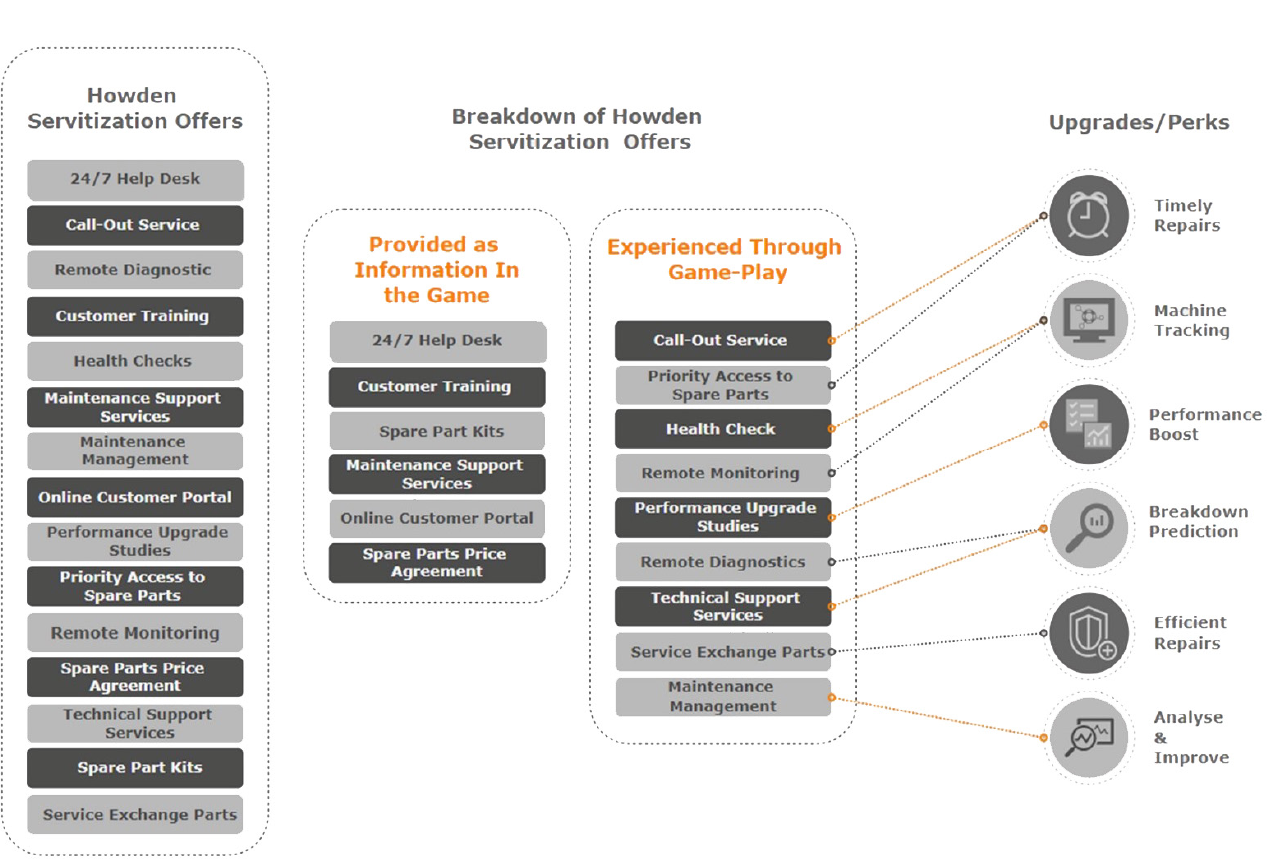
Figure 3. Alignment of Howdens DEAS offers with the Learning Outcome and Game Upgrades.